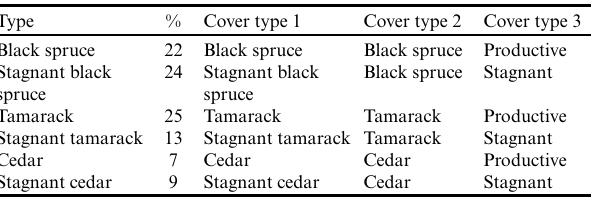
Table 3 . Proportion of lowland conifer types within state-owned lowland conifer of the Agassiz Lowland Subsection. Lowland conifer cover types (Type) sampled for birds were combined into three separate variables used in analyses of habitat associations; segregated by tree species and productivity (cover type 1), tree species only (cover type 2), and productivity only (cover type